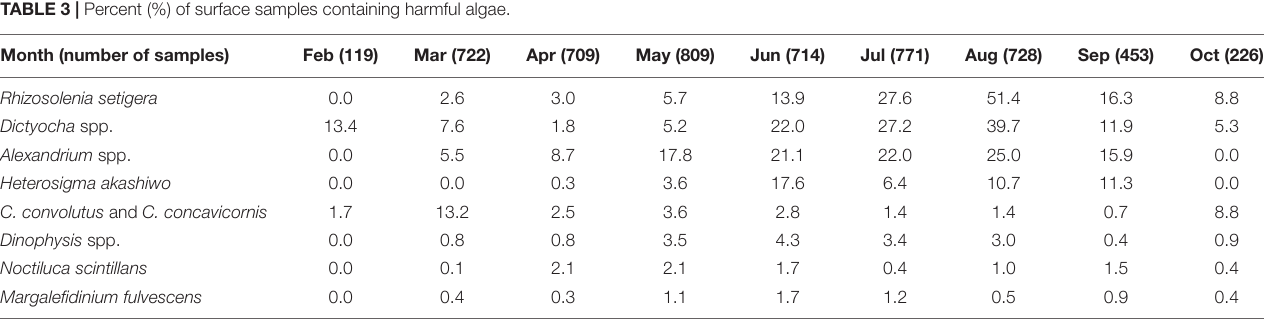
TABLE 3 | Percent (%) of surface samples containing harmful